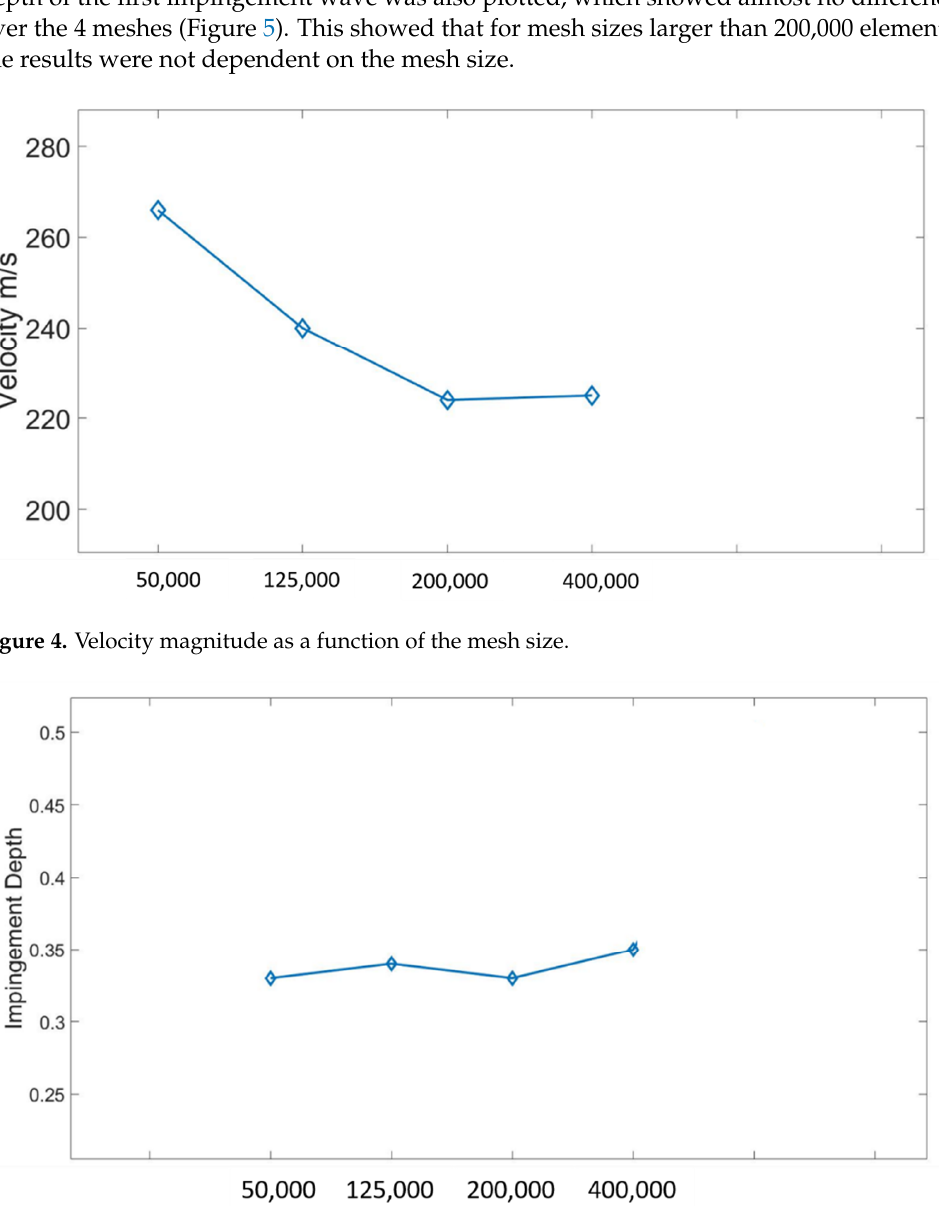
Figure 5. Impingement depth as a function of the mesh